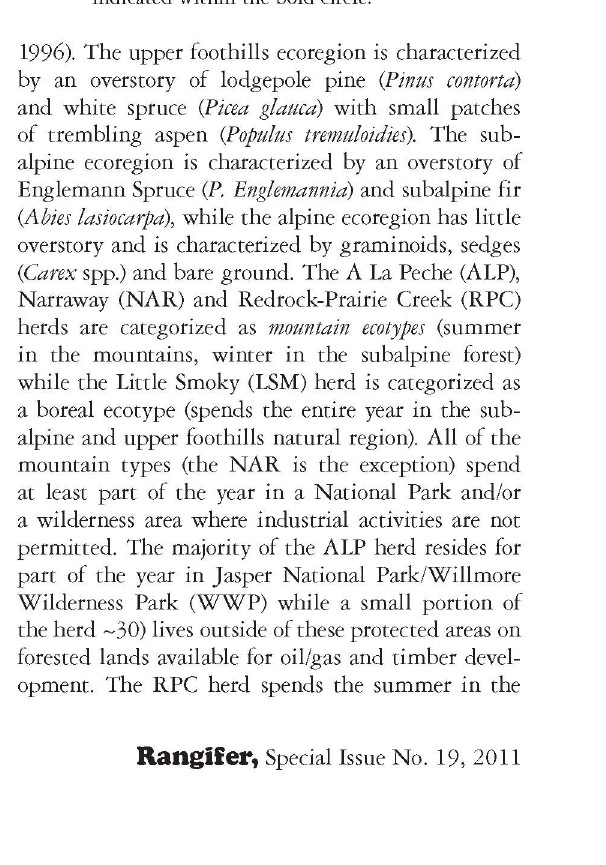
Fig. 1. Locations of woodland caribou herds in west central Alberta, Canada. Herds in west central Alberta that were examined in this study are indicated within the bold